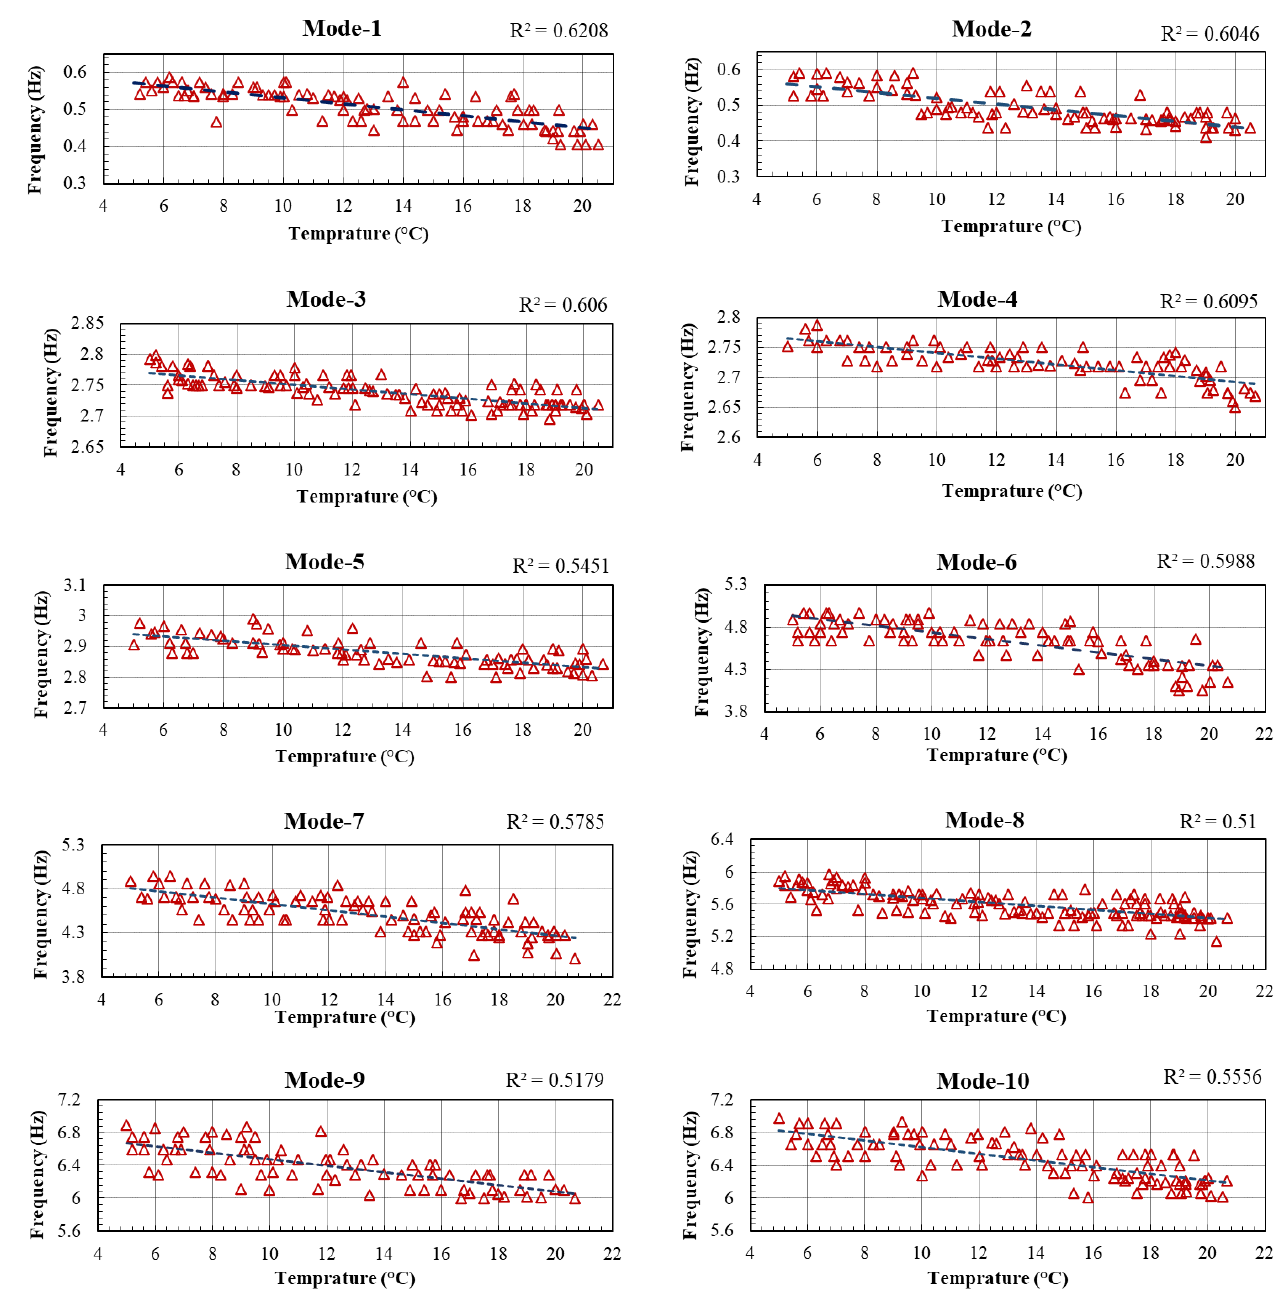
Figure 10. The correlation between the identified frequencies and the ambient temperature